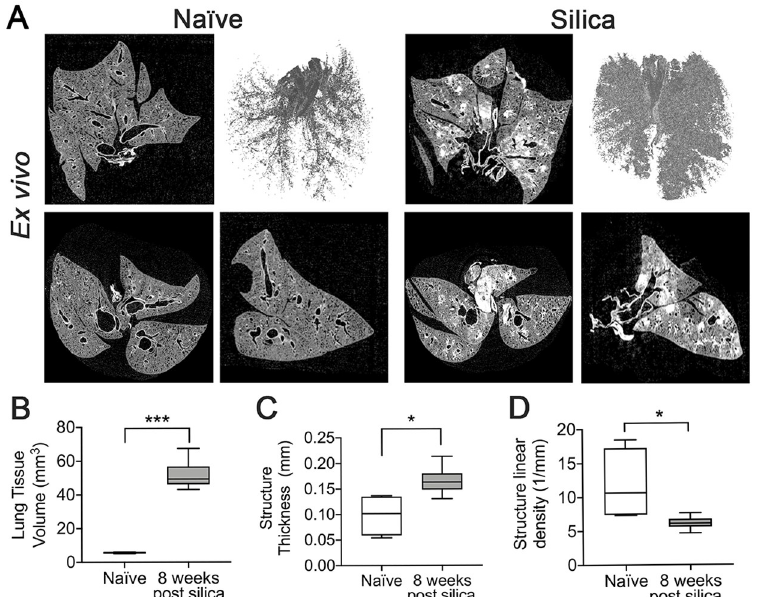
Fig 5. Post-mortem imaging of fixed ex vivo lungs. (A) microCT images from chemically dried lungs scanned using a Bruker Skyscan 1176 at 9 μ m resolution from na ï ve mice (left panels) (n = 4), and mice 8 weeks post silica-instillation (right panels) (n = 6). Representative images of coronal (top left), transverse (bottom left), and sagittal (bottom right) slices and a 3D surface rendering of tissue volume (top right) are shown. Quantification of (B) structure thickness, (C) lung tissue volume and (D) structure linear density were generated using the ex vivo task list. Graphed as box and whisker plot (min, max with mean). � p < 0 . 05 , ��� p < 0 . 001 ,2-tailed t-test with Welch’s correction.